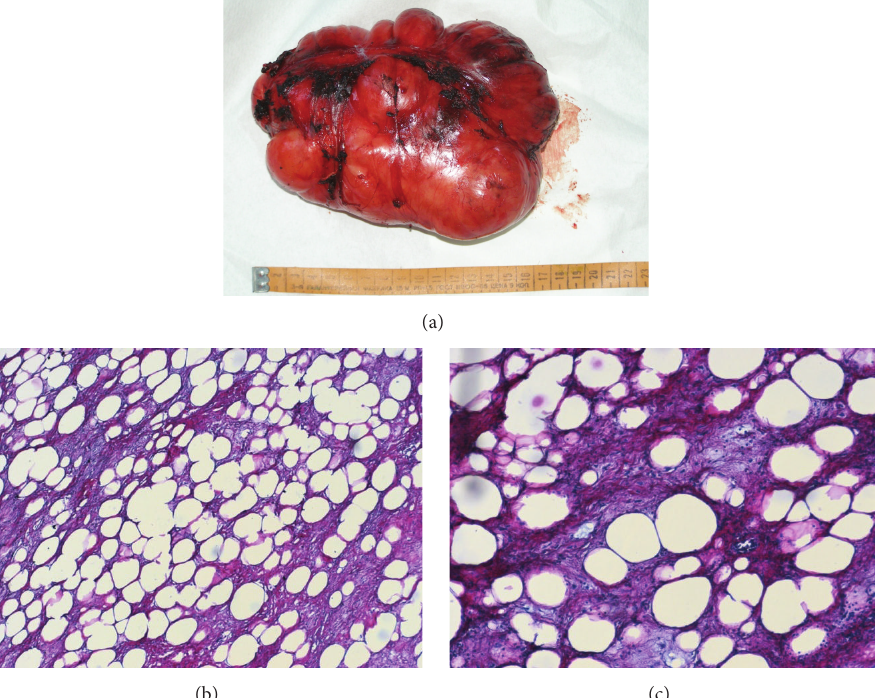
Figure 4: Operative specimen (a) and pathologic examination—hematoxylin-eosin 5x (b) and 10x (c) showing a myxoid spindle cell